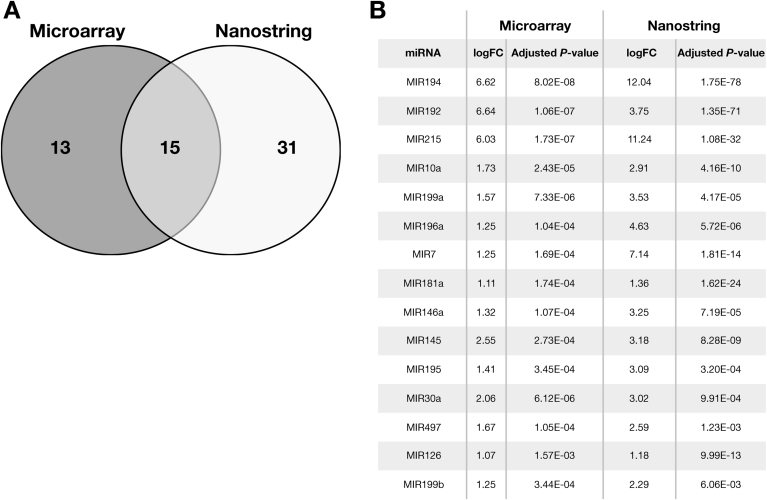
Up-regulated miRNAs from cross-platform analysis. (A) Venn diagram showing up-regulated miRNAs detected by Agilent microarray and Nanostring profiling in Selection sample sets A and B respectively. Detailed fold changes for each up-regulated miRNA listed in Supplementary Tables 2 and 3. Fifteen consensus miRNAs were determined by cross-referencing of miRNAs detected by each platform. Log of fold changes (logFC) and adjusted P values of these 15 miRNAs are listed in (B), ranked by mean of adjusted P value.